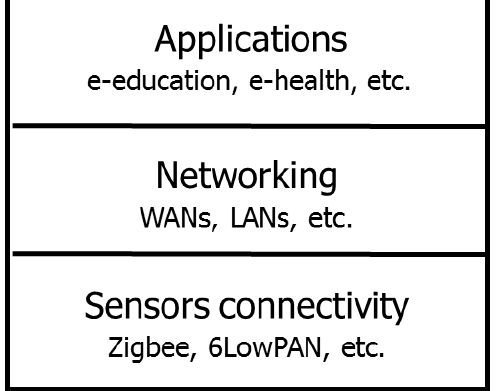
Fig. 1. Overall IOT